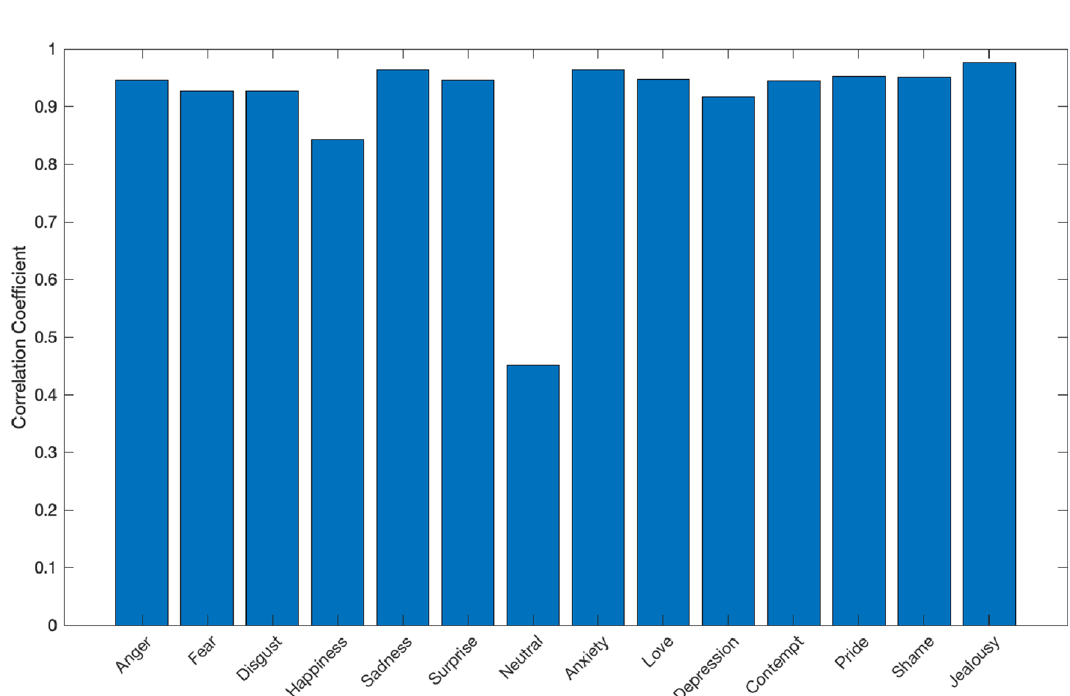
Figure 6. The similarity (Spearman’s correlation coefficient) between the BSMs of corresponding emotions in the current and previous study 8